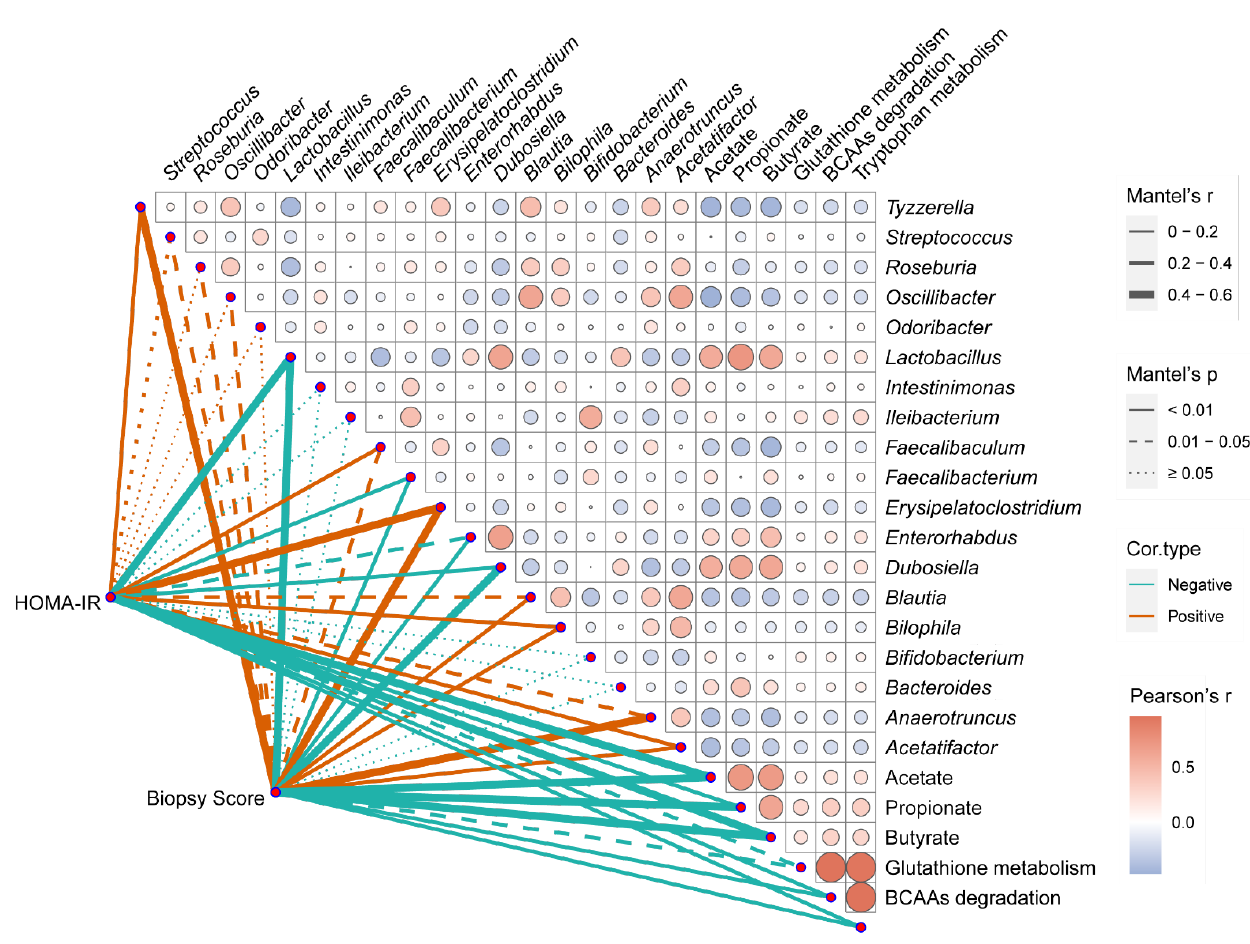
Figure 6. Correlation analysis of representative phenotypes of NAFLD to gut microbial indicators. The color and size of the circles in the matrix code indicate the correlation level. The thickness, color, and type (solid or dot) of the lines represent the correlation level, correlation type, and p value level, respectively. The correlation analyses in intra-matrix or inter-matrix are based on Pearson’s correlation coefficient and Mantel’s test, respectively. BCAAs, valine, leucine, and isoleucine degradation; HOMA-IR, homeostatic model assessment for insulin resistance; Biopsy score indicates the sum of the hepatic steatosis grade and the inflammation grade.